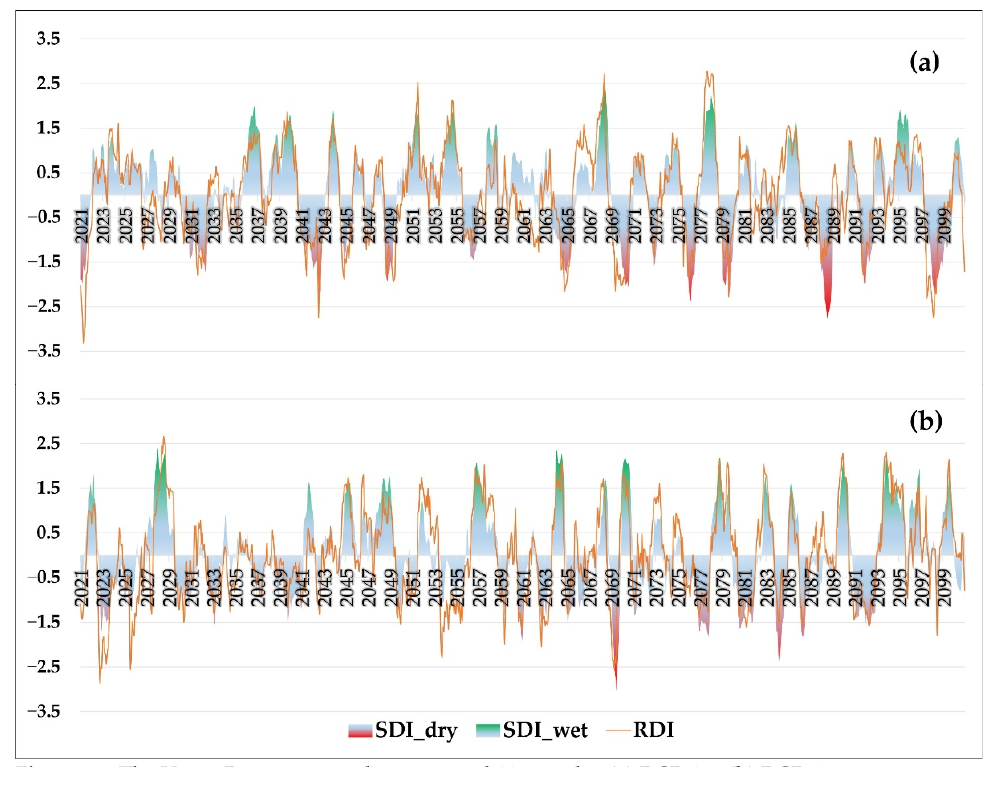
Figure 14. The Venta River, accumulation period 12 months: ( a ) RCP 4.5; ( b ) RCP 8.5.